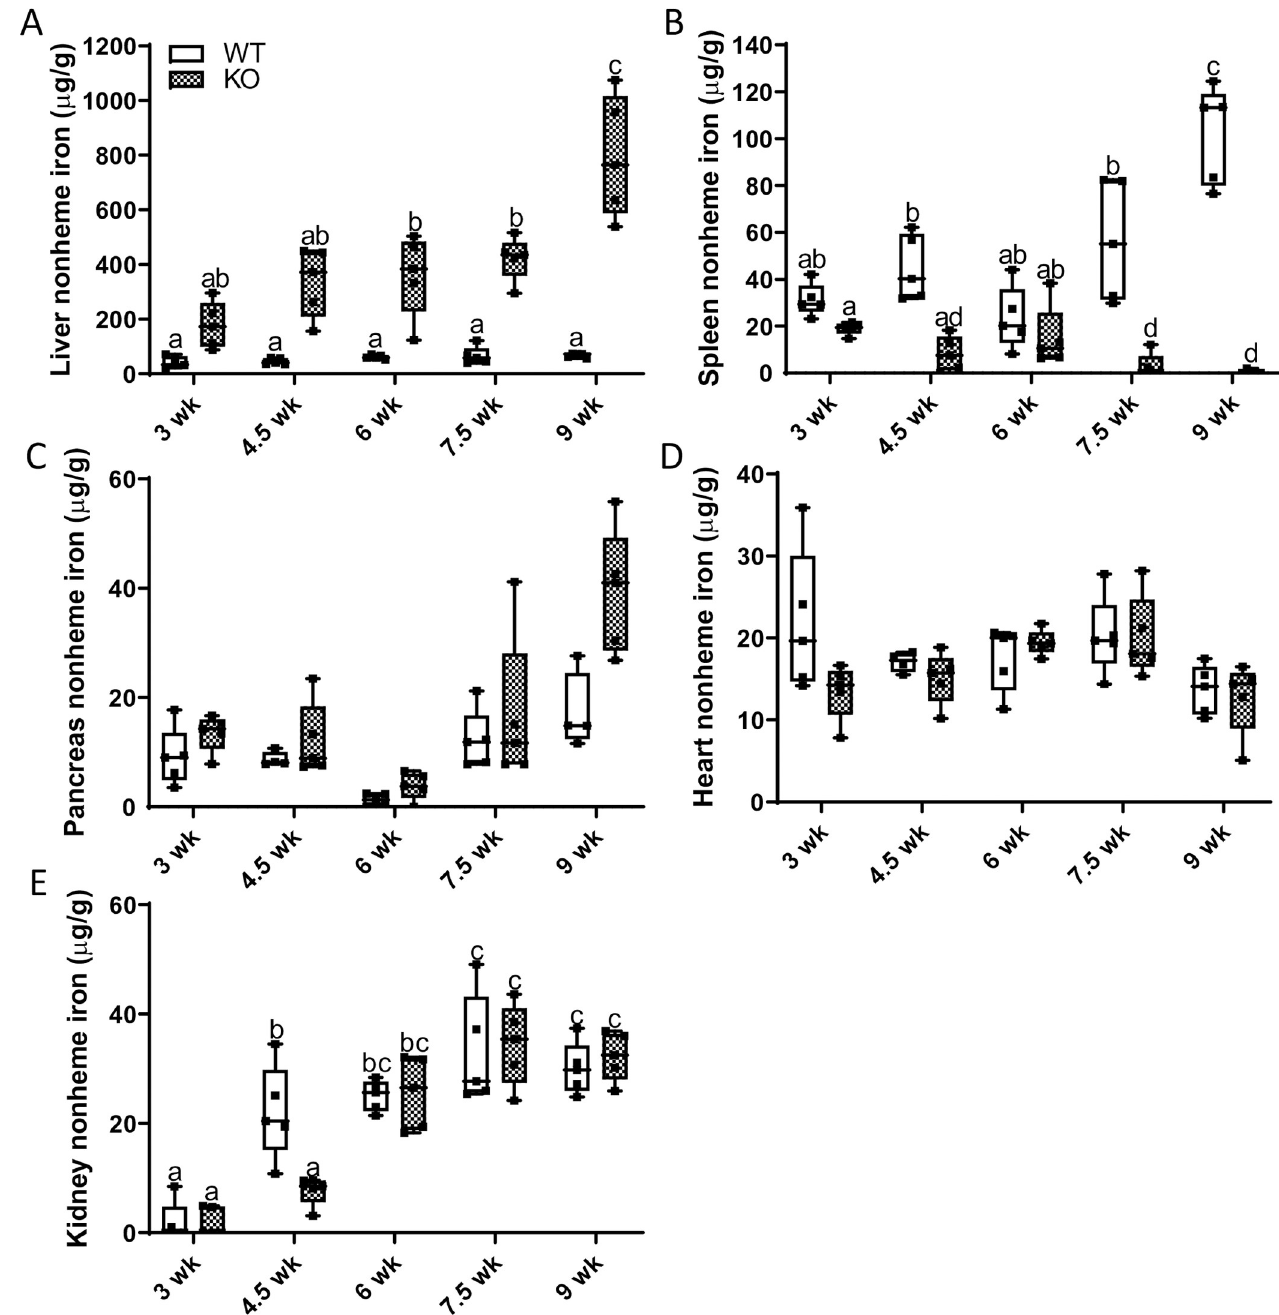
Fig 5. Hepatic iron loading and splenic iron depletion begins shortly after weaning in male Hamp KO rats. To determine the chronology of iron loading, tissue nonheme iron concentrations were assessed every week and a half beginning at weaning in rats of both genotypes. Shown are nonheme iron levels in the liver ( A ), spleen ( B ), pancreas ( C ), heart ( D ) and kidney ( E ). Data are presented as box plots for n = 4–5 rats per group. All data were log transformed before being analyzed by 2-way ANOVA followed by Tukey’s multiple comparisons test; however, the untransformed data are presented for ease of interpretation. Groups without a common letter differ significantly ( p � 0.014). Genotype × Age, p � 0.019 ( A, B, E ); Genotype, p < 0.0001( A, B ); Age, p � 0.016 ( A-E ). brown (instead of dark red) and having a metallic sheen (Fig 10C). This splenic abnormality was documented in 65% of males (n = 32) that were sacrificed at > 9 months of age, and 13% of